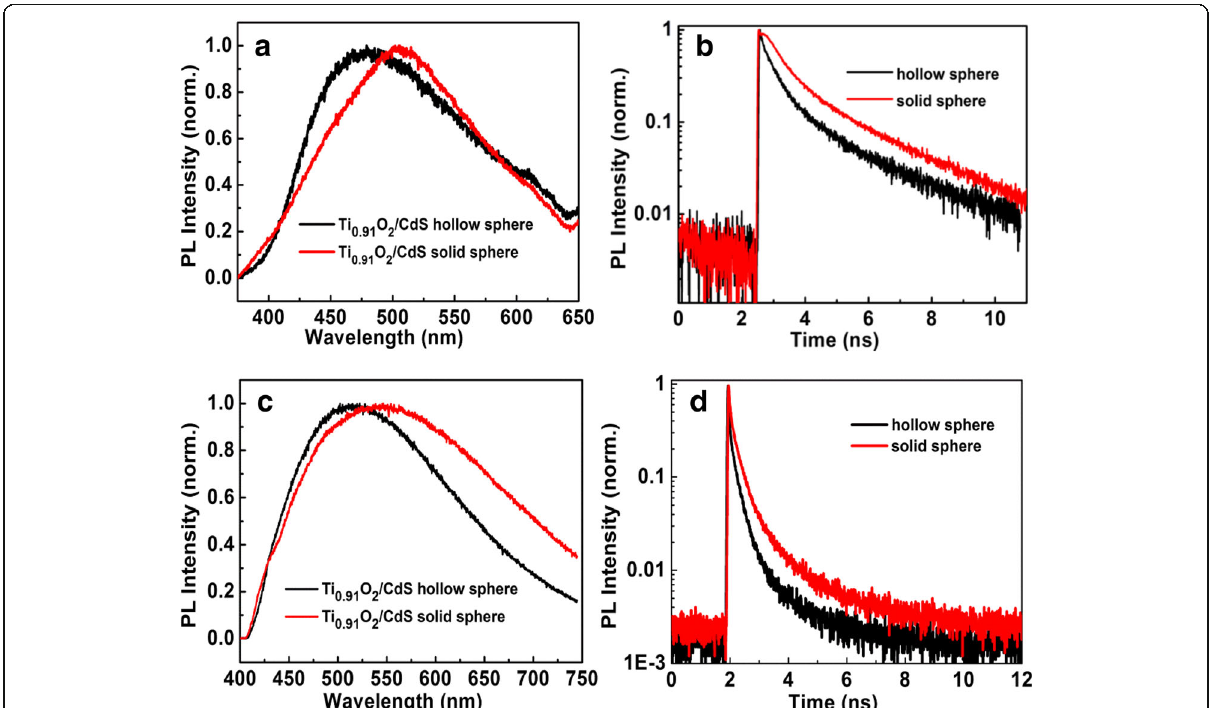
Fig. 3 a PL spectra of hollow Ti 0.91 O 2 /CdS (black) and solid Ti 0.91 O 2 /CdS (red) samples excited at 266 nm. b PL decay curves of hollow Ti 0.91 O 2 /CdS (black) and solid Ti 0.91 O 2 /CdS (red) samples with the 266 nm excitation. c PL spectra of hollow Ti 0.91 O 2 /CdS (black) and solid Ti 0.91 O 2 /CdS (red) samples excited at 400 nm. d PL decay curves of hollow Ti 0.91 O 2 /CdS (black) and solid Ti 0.91 O 2 /CdS (red) samples with the 400 nm